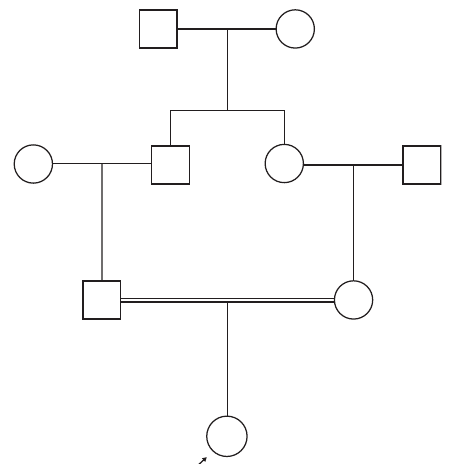
Figure 1: Genogram illustrating the consanguinity.